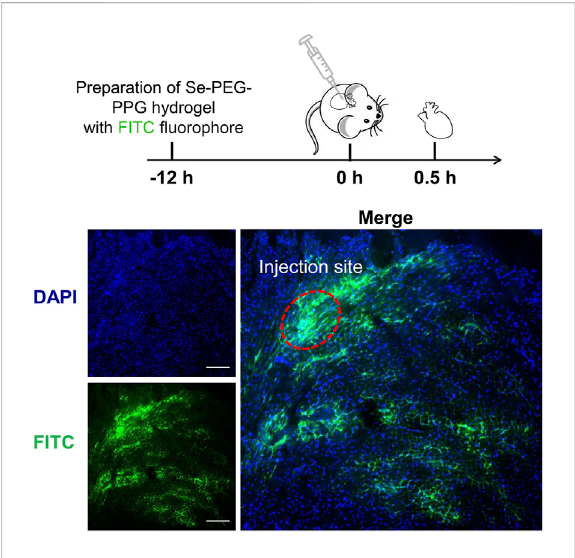
FIGURE 3 Representative sectioning and imaging of myocardium